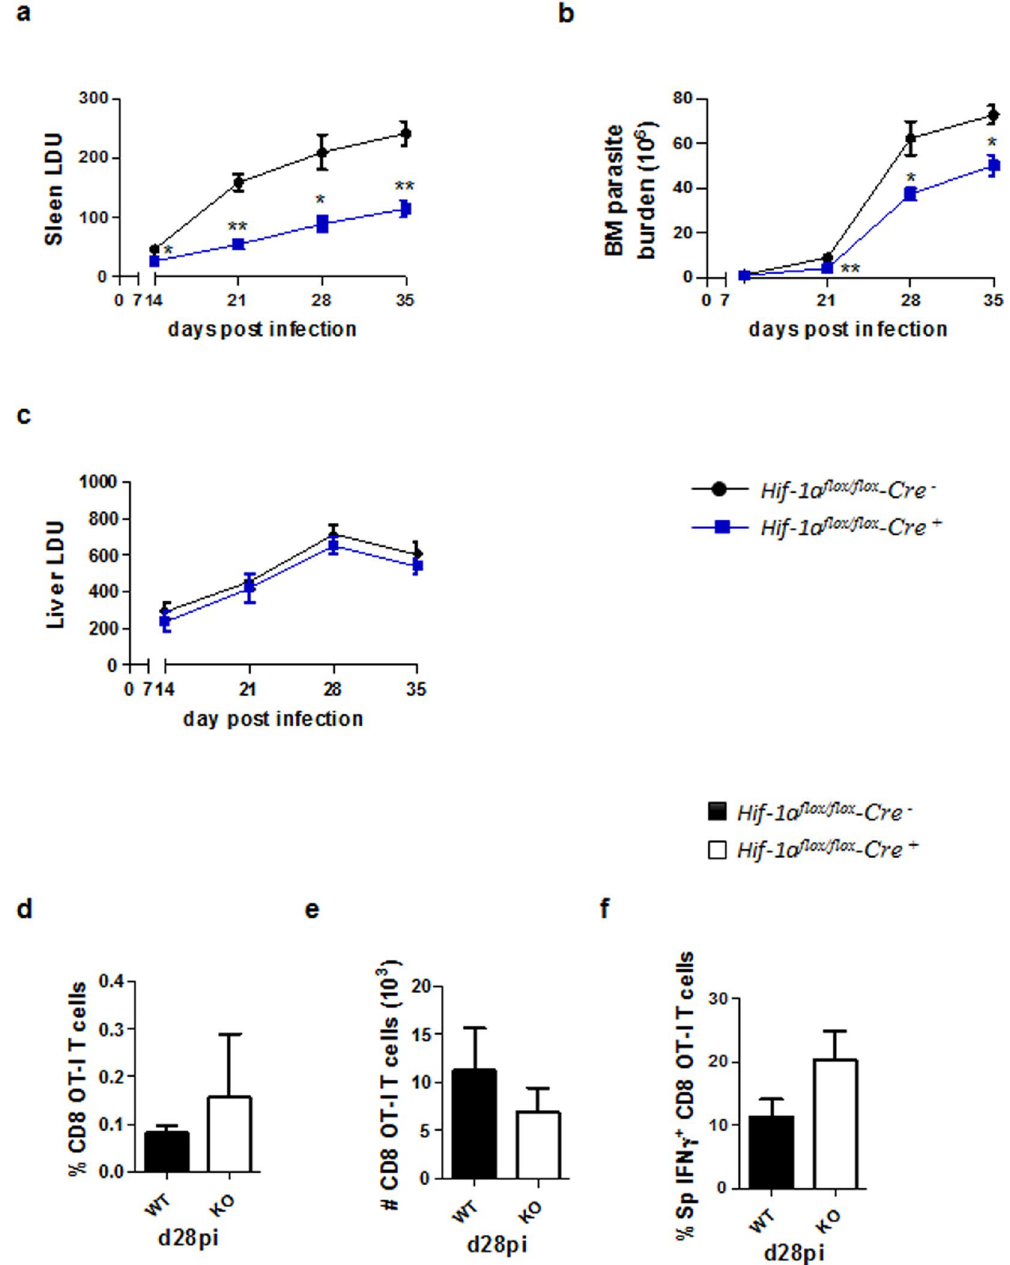
Figure 1. CD11c-specific HIF-1 α ablation results in lower parasite burdens in the spleen and bone marrow. Hif-1 α flox/flox Cd11c-Cre − (WT) and Hif-1 α flox/flox Cd11c-Cre + (KO) mice were infected with 2 × 10 7 amastigotes intravenously. ( a ) Graph represents the splenic parasite burden expressed as Leishman Donovan Units (LDU) at various time points after infection. ( b ) Bone marrow parasite burden, determined by limiting dilutions. ( c ) Liver parasite burden (LDU). ( d – f ) 2 × 10 4 OT-I CD8 T cells were adoptively transferred into recipient mice a day prior to infection with ovalbumin-transgenic (PINK) L. donovani amastigotes. ( d ) Graph represents the percentage of OT-I CD8 T cells found in the spleen from Hif-1 α flox/flox Cd11c-Cre − and Hif-1 α flox/flox Cd11c-Cre + mice over the course of infection. ( e ) The average number of OT-I CD8 T cells. ( f ) The frequency of IFN γ + OT-I CD8 T cells. All data represent mean ± SEM of one of 3 independent experiments, n =